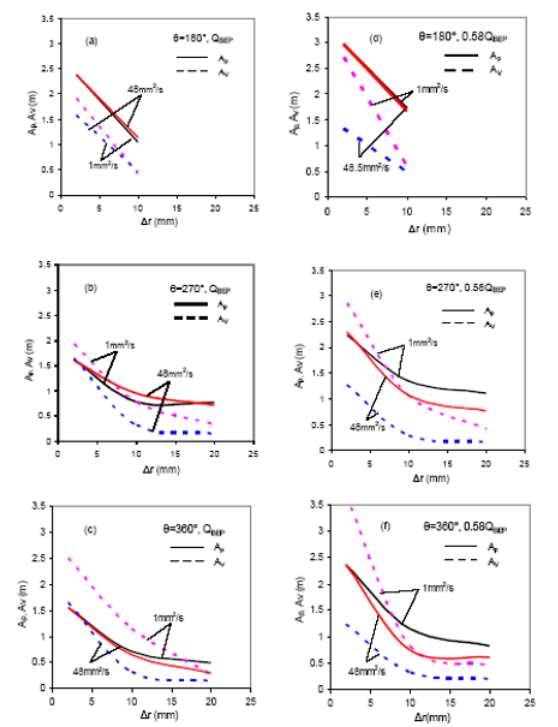
Figure 8. Amplitude decay of pressure and velocity heads of water and viscous oil behind impeller at best efficiency (a)-(c) andpart-loading(e)-(f)points, A p and A V arepeak-to-peak amplitudes of static pressure and velocity head.